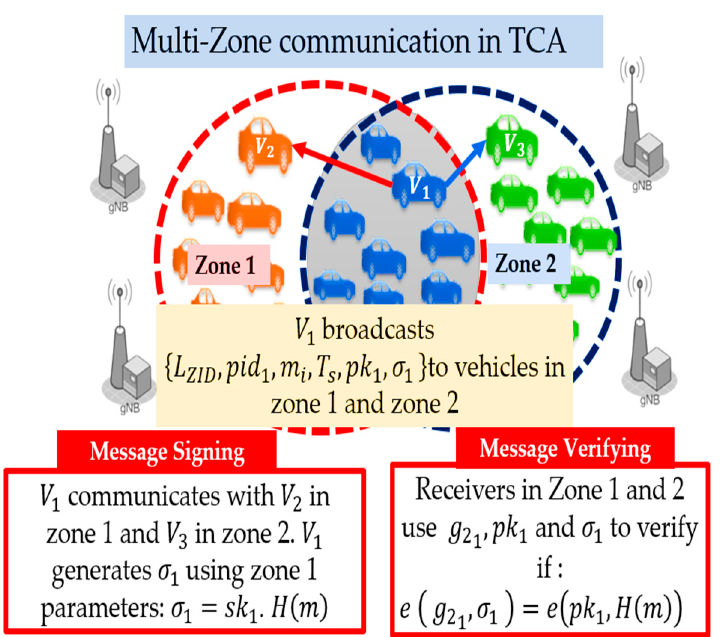
Figure 7. Multi-zone communication in TCA.